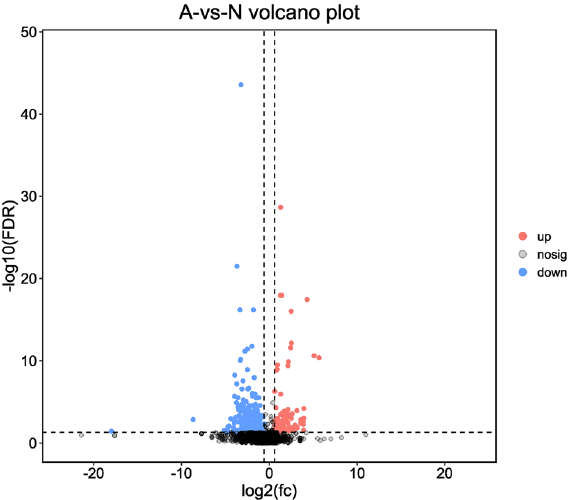
Figure 2. A volcano plot of urinary proteins identified in adult (group A) and neonatal (group N) donkeys. Red dots and blue dots represented upregulated and downregulated proteins in group N compared to proteins in group A,